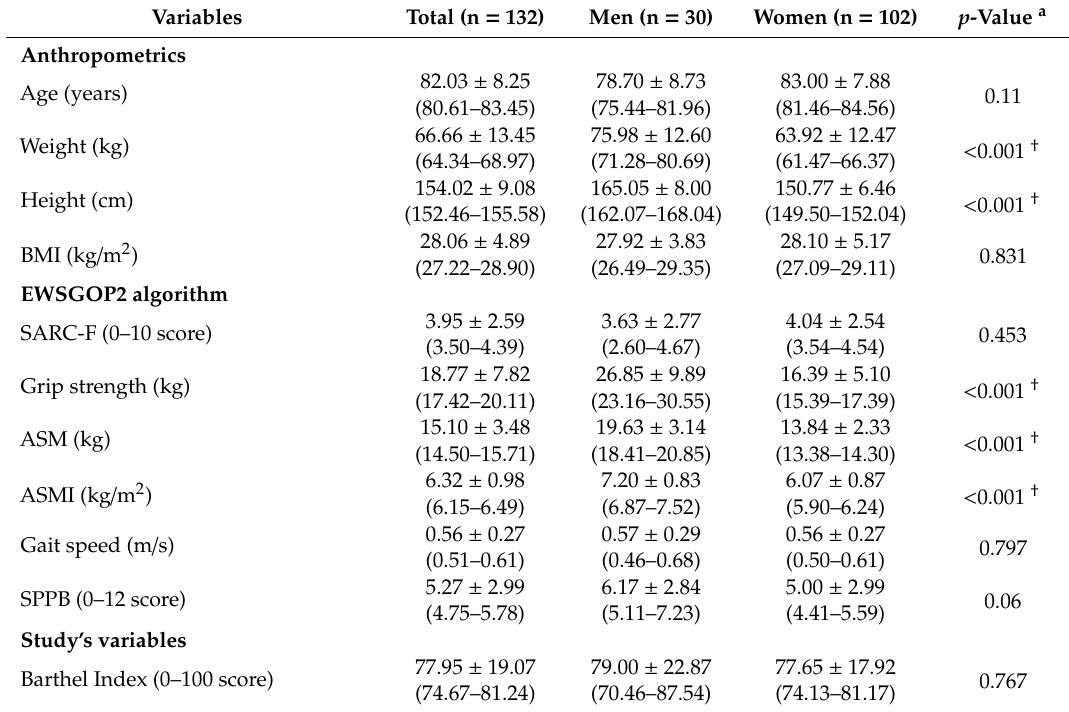
Table 1. Characteristics of the participants according to gender: mean ± standard deviation and (95% confidence interval) or number of cases